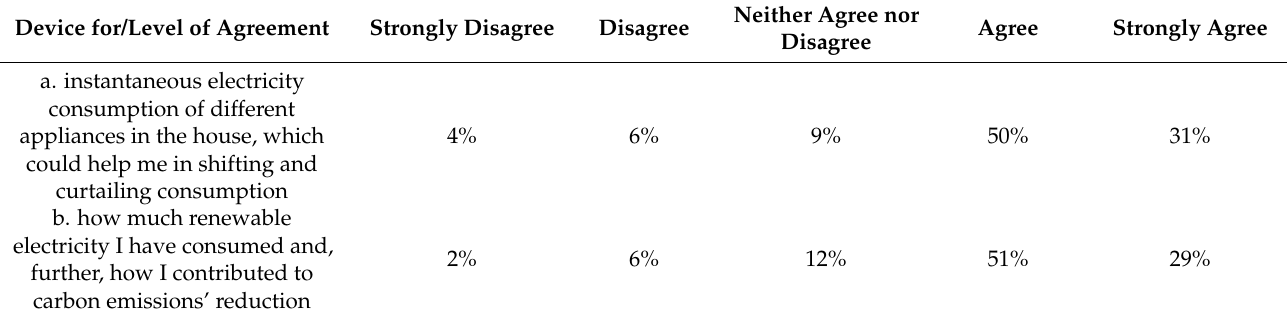
Table 6. Consumers’ preferences in using devices for electricity consumption